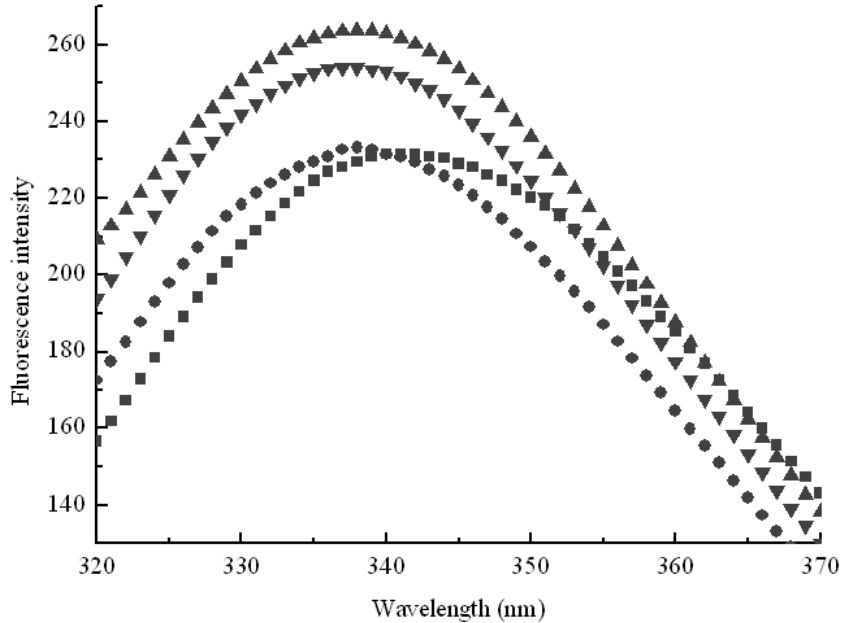
Figure 3. Effects of geometric dimension of hydrophobic cavities on intrinsic fluorescence of pullulanase in the absence of CDs ( ■ ) and in the presence of α -CD ( ● ), β -CD ( ▲ ), γ -CD ( ▼ ). Each data point was the mean of three